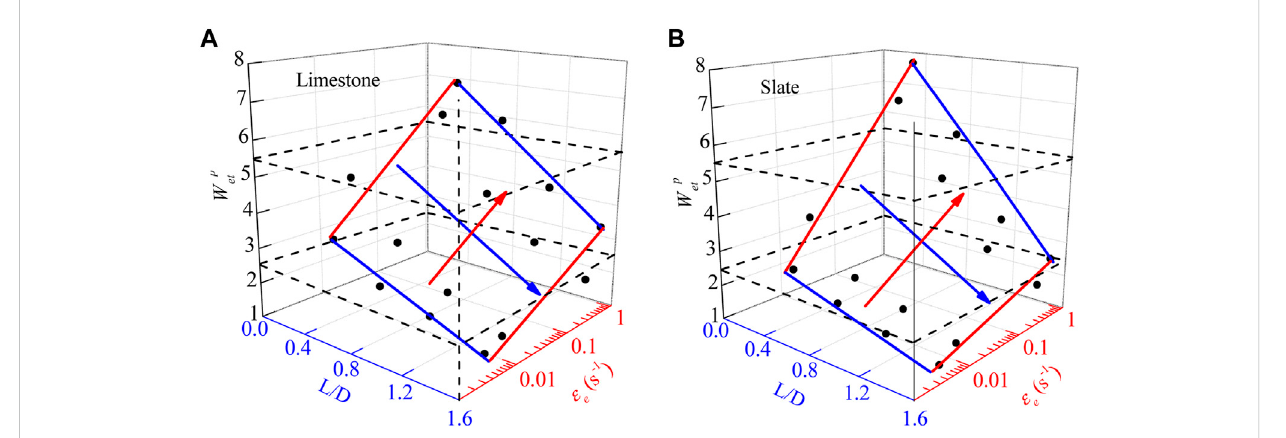
FIGURE 12 Variation of W p et with different L/D ratios and strain rates for (A) Limestone and (B)